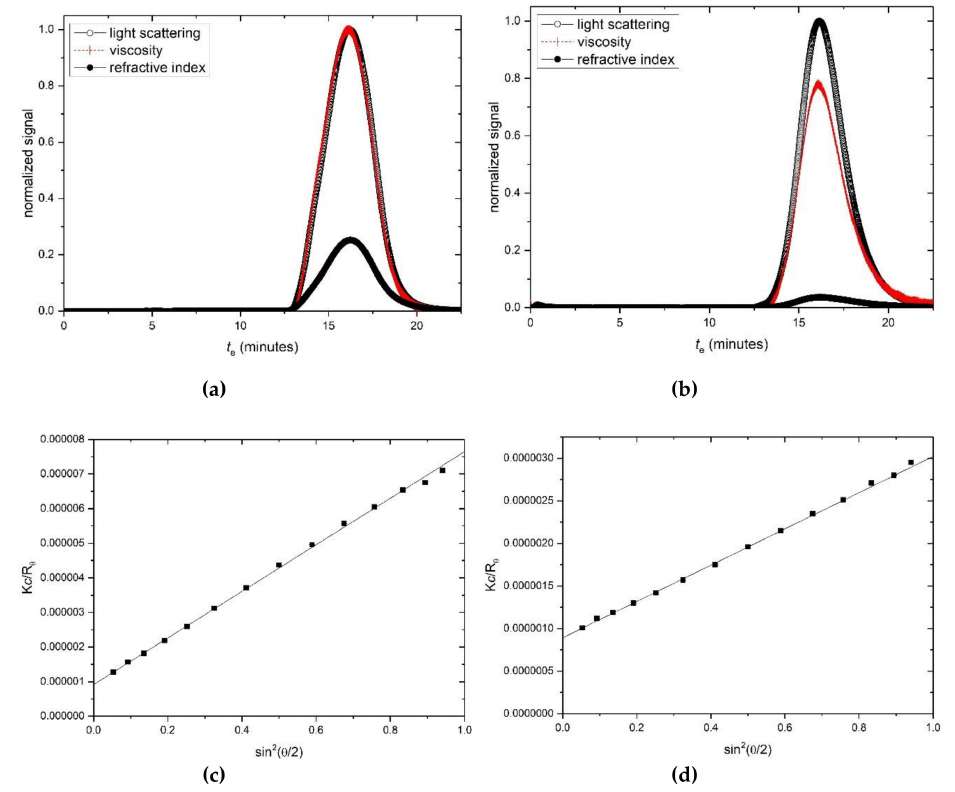
Figure 3. Size exclusion chromatography—multiangle light scattering (SEC-MALS) elution profiles for ( a ) hyaluronic acid, HA and ( b ) tamarind seed polysaccharide, TSP. Solid black circles: light scattering signal at a scattering angle θ = 90 ◦ . Open circles: concentration (refractive index) signal; dashed line: di ff erential pressure (viscosity) signal; t e = elution time. ( c ) Zimm fit of K c / R θ (see text for definitions) vs sin 2 ( θ / 2) for HA, at a single elution time t e . ( d ) Corresponding plot for TSP. Solution pH = 6.8, I = 0.1, temperature = 20.0 ◦